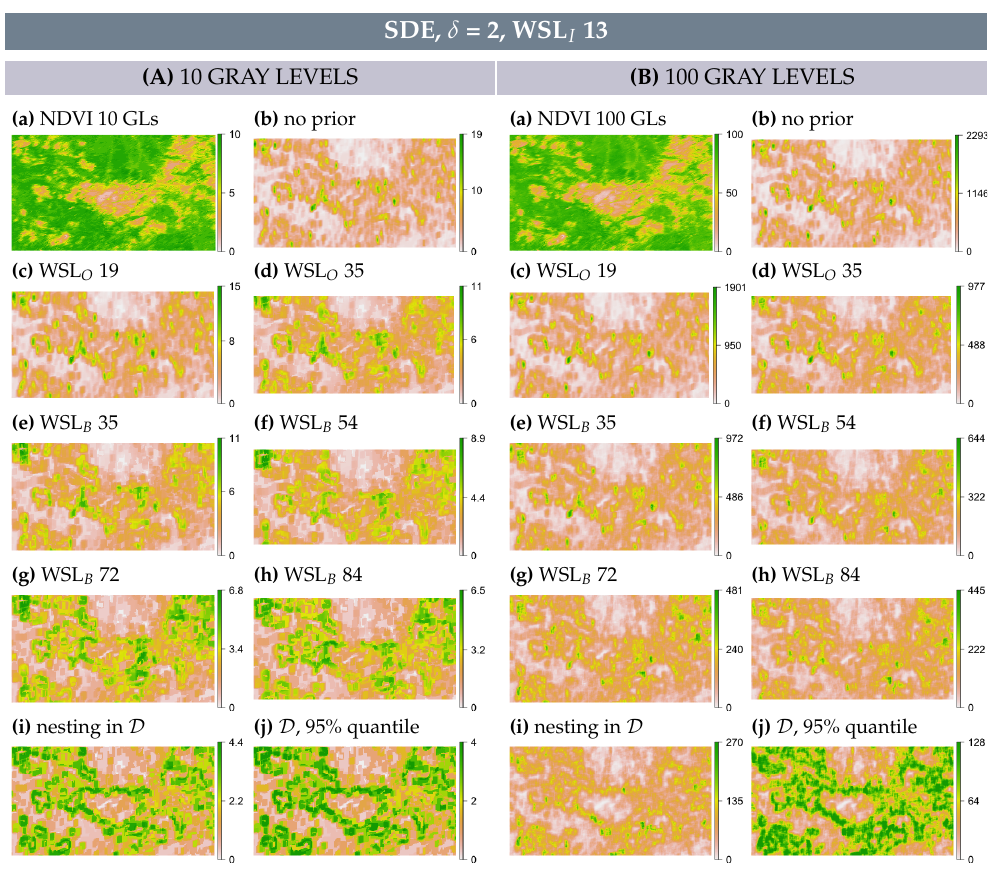
Figure 6. Structural diversity entropy (SDE), δ = 2, WSL I 13. Minimum values displayed are set to 0. (A,B) (j) Nesting in D , 95%